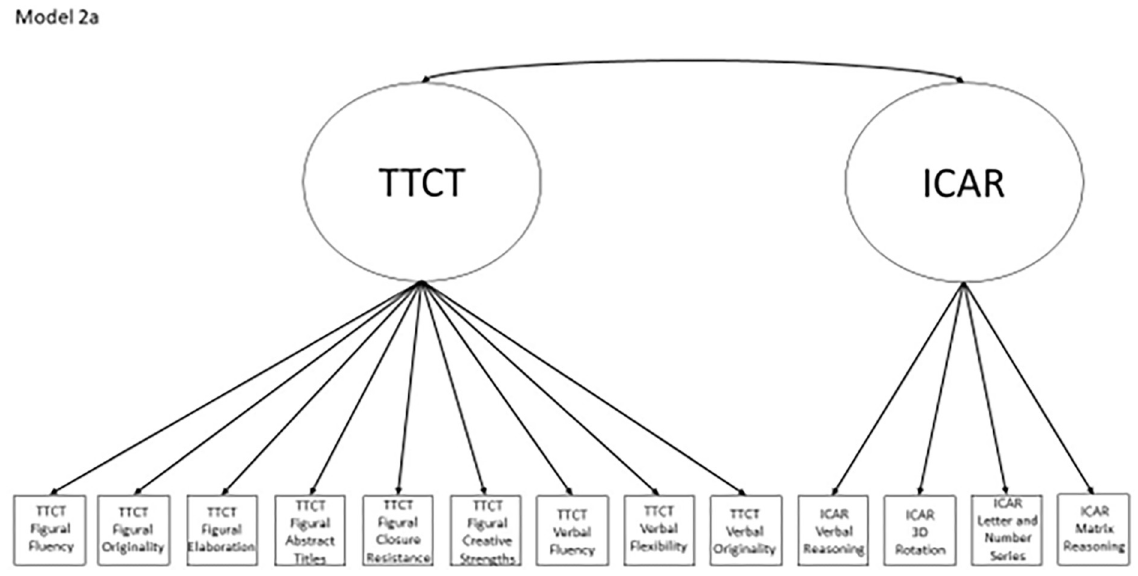
Fig 3. Confirmatory factor analysis diagram for model